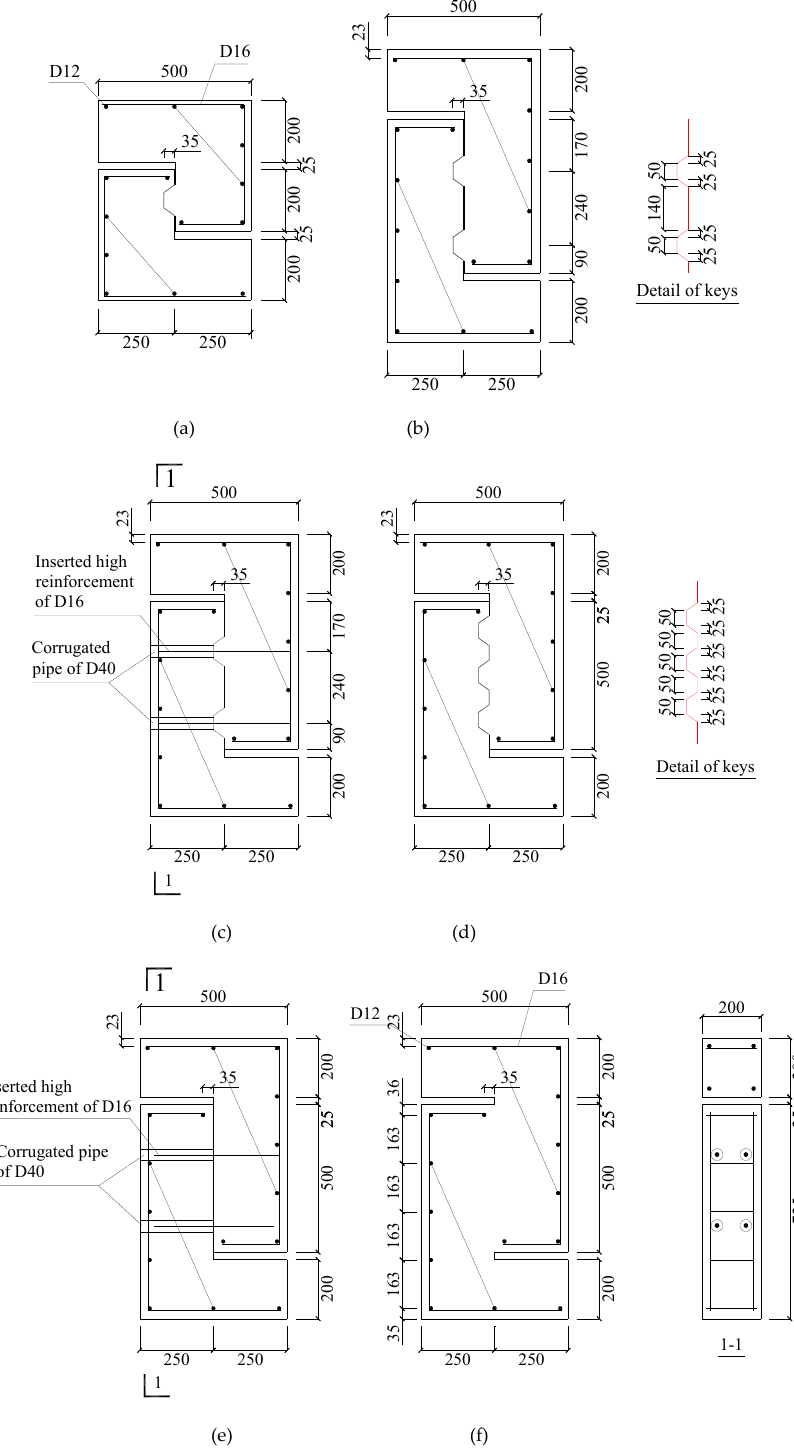
Figure 3. Typical dimensions of flat and keyed joints with/without reinforcement: ( a ) detail of a single keyed joint; ( b ) detail of a two-keyed joint; ( c ) two-keyed joint with reinforcement; ( d ) three-keyed joint; ( e ) detail of a flat joint with reinforcement; ( f ) monolithic cast-in-place specimen. The test information matrix for each specimen is listed in Table 1. The identifier of the specimens is represented by four groups of characters, i.e., Mi-D (or E), -Ki (or F), -R (or N), and CIP,